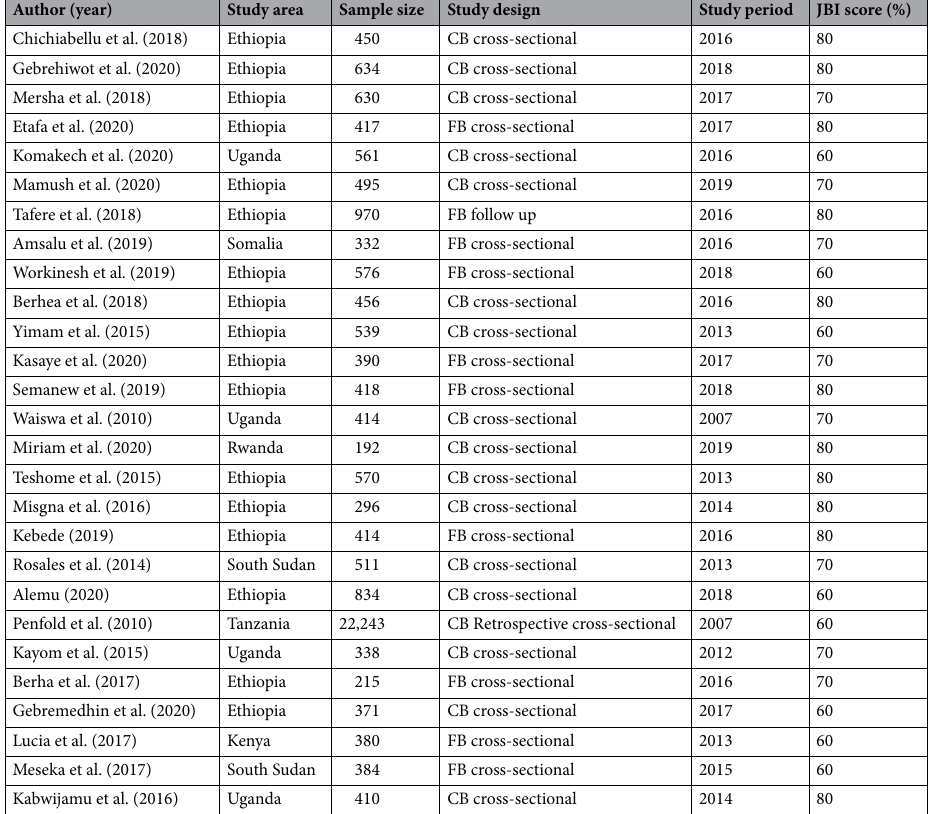
Table 1. Characteristics of included studies to explore the effect of ANC follow up on Essential newborn care practice in East